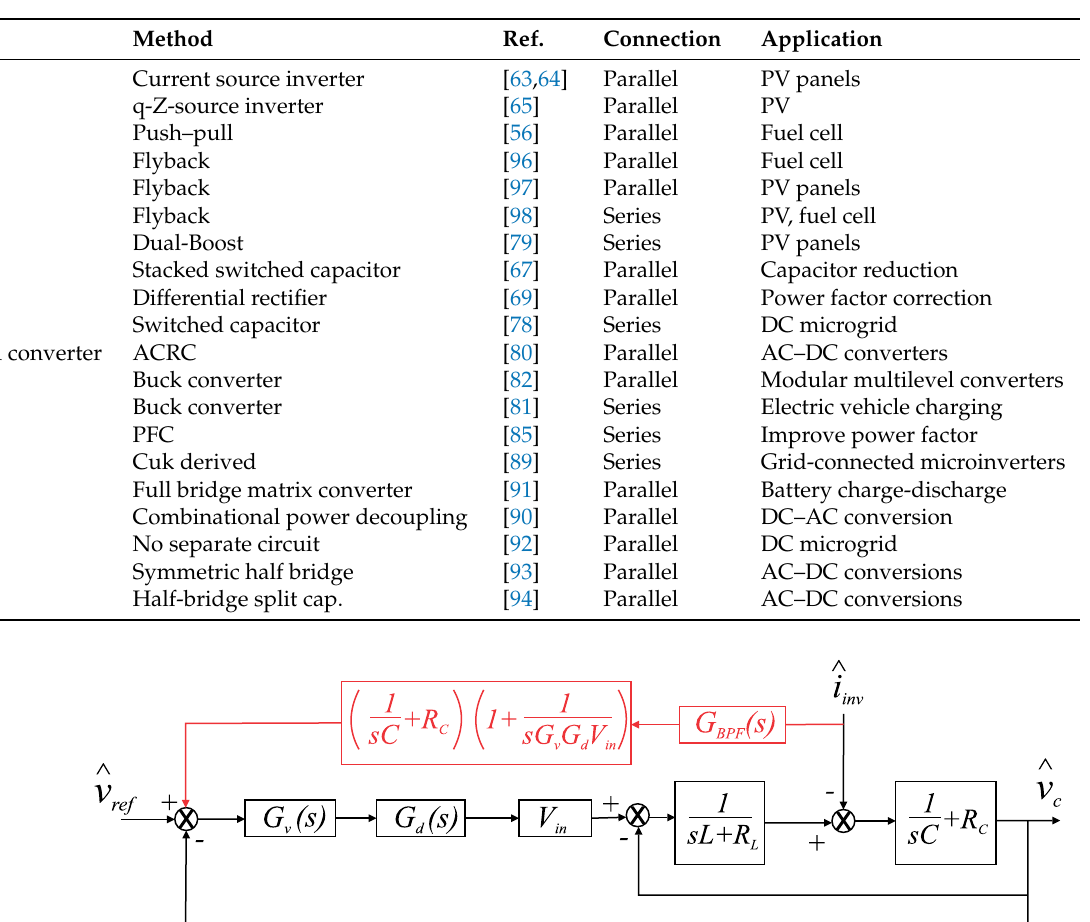
Table 1. Summary of active control methodologies.